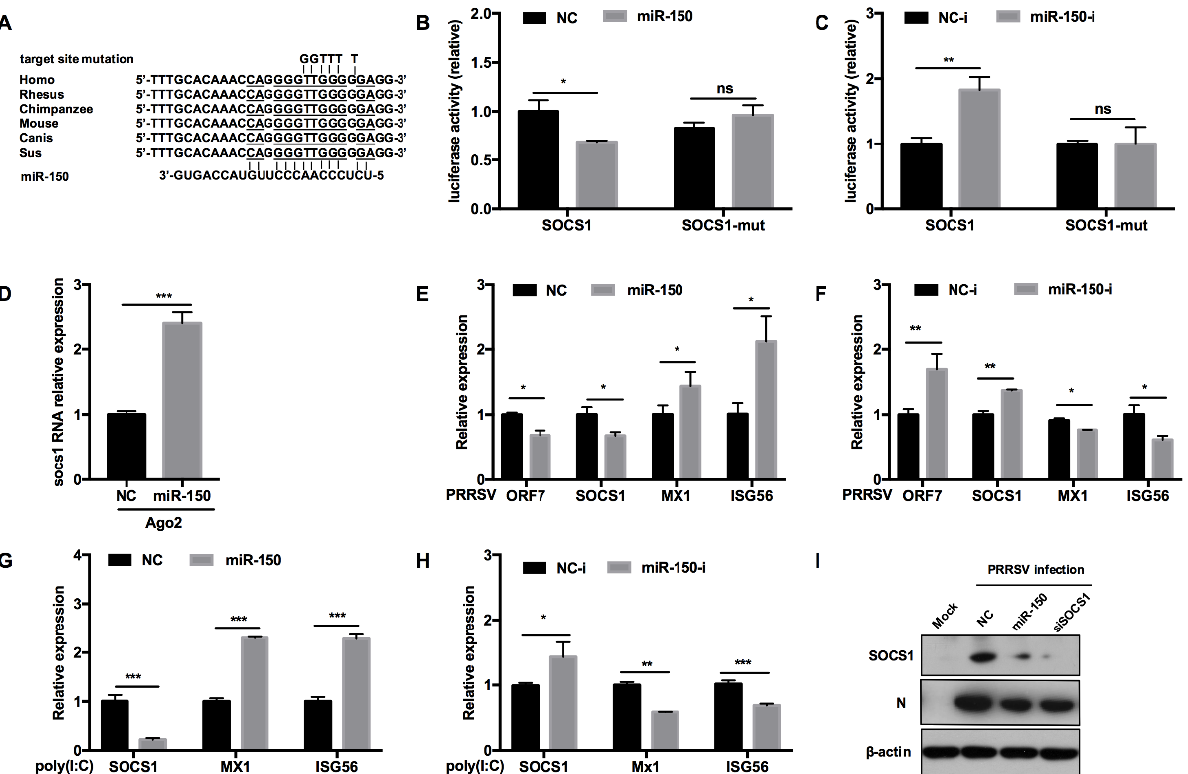
Figure 6. miR-150 promotes type I IFN responses by targeting SOCS1. ( A ) Schematic diagram of the predicted target sites of miR-150 in SOCS1 3 (cid:48) UTR and target sites of six representative mammals. The predicted target sites of miR-150 were mutated as indicated. ( B , C ) Marc-145 cells were co-transfected with SOCS1 3 (cid:48) UTR or SOCS1 3 (cid:48) UTR mutant luciferase reporter vector, pRL-TK, and miR-150 mimics or miR-150 inhibitor (miR-150-i) for 36 h and then harvested for luciferase assay. ( D ) qRT-PCR analysis of SOCS1 3 (cid:48) UTR among RNAs extracted from RISC immunoprecipitates of the cells, which is indicated in Figure 5D. ( E – H ) PAMs were transfected with miR-150 mimics or miR-150 inhibitors (miR-150-i) at a final concentration of 60 nM for 24 h, followed by infection with HV-PRRSV (HV isolate) (MOI = 0.5) for 24 h or stimulating with poly(I:C) (10 µ g/mL) for 24 h. Total RNA was extracted and qRT-PCR was used to analyze ORF7, SOCS1, Mx1, and ISG15 expression. ( I ) PAMs were transfected with miR-150 mimics, siRNA-SOCS1 (an equimolar mixture of two siRNAs), or NC at a final concentration of 60 nM for 24 h, followed by infection with HV-PRRSV (HV isolate) for 36 h at an MOI of 0.5. Cells were harvested for PRRSV protein N and SOCS1 protein detection using Western blot analysis. The data are representative of three independent experiments (means ±